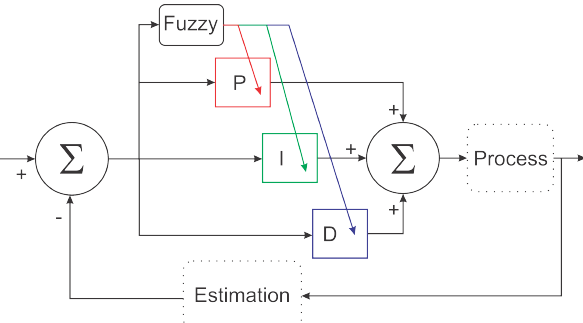
Figure 3. Fuzzy logic implementation.